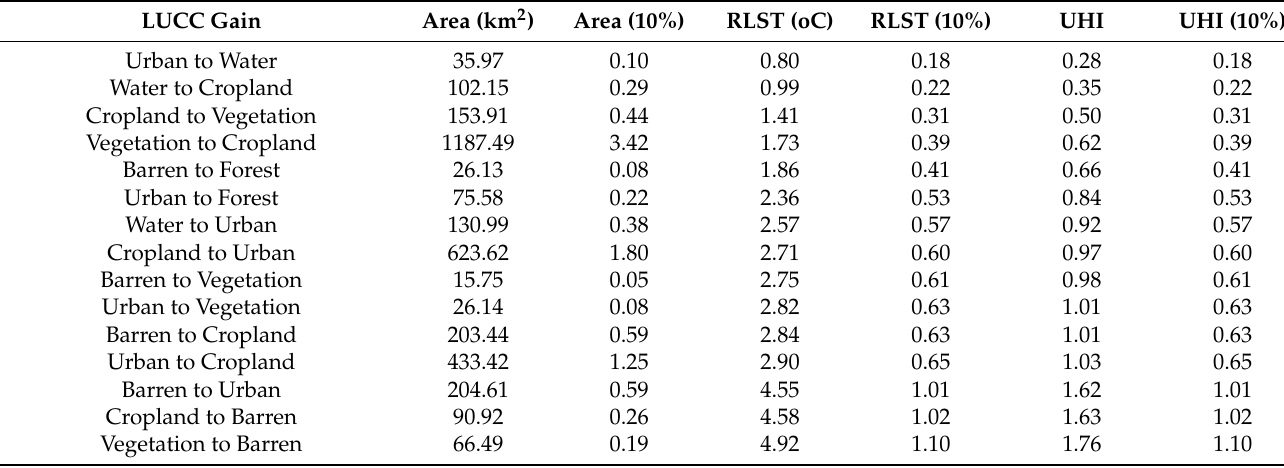
Table 5. Statistics of the predicted LUCC area (km 2 ) for 2025 and 2050.